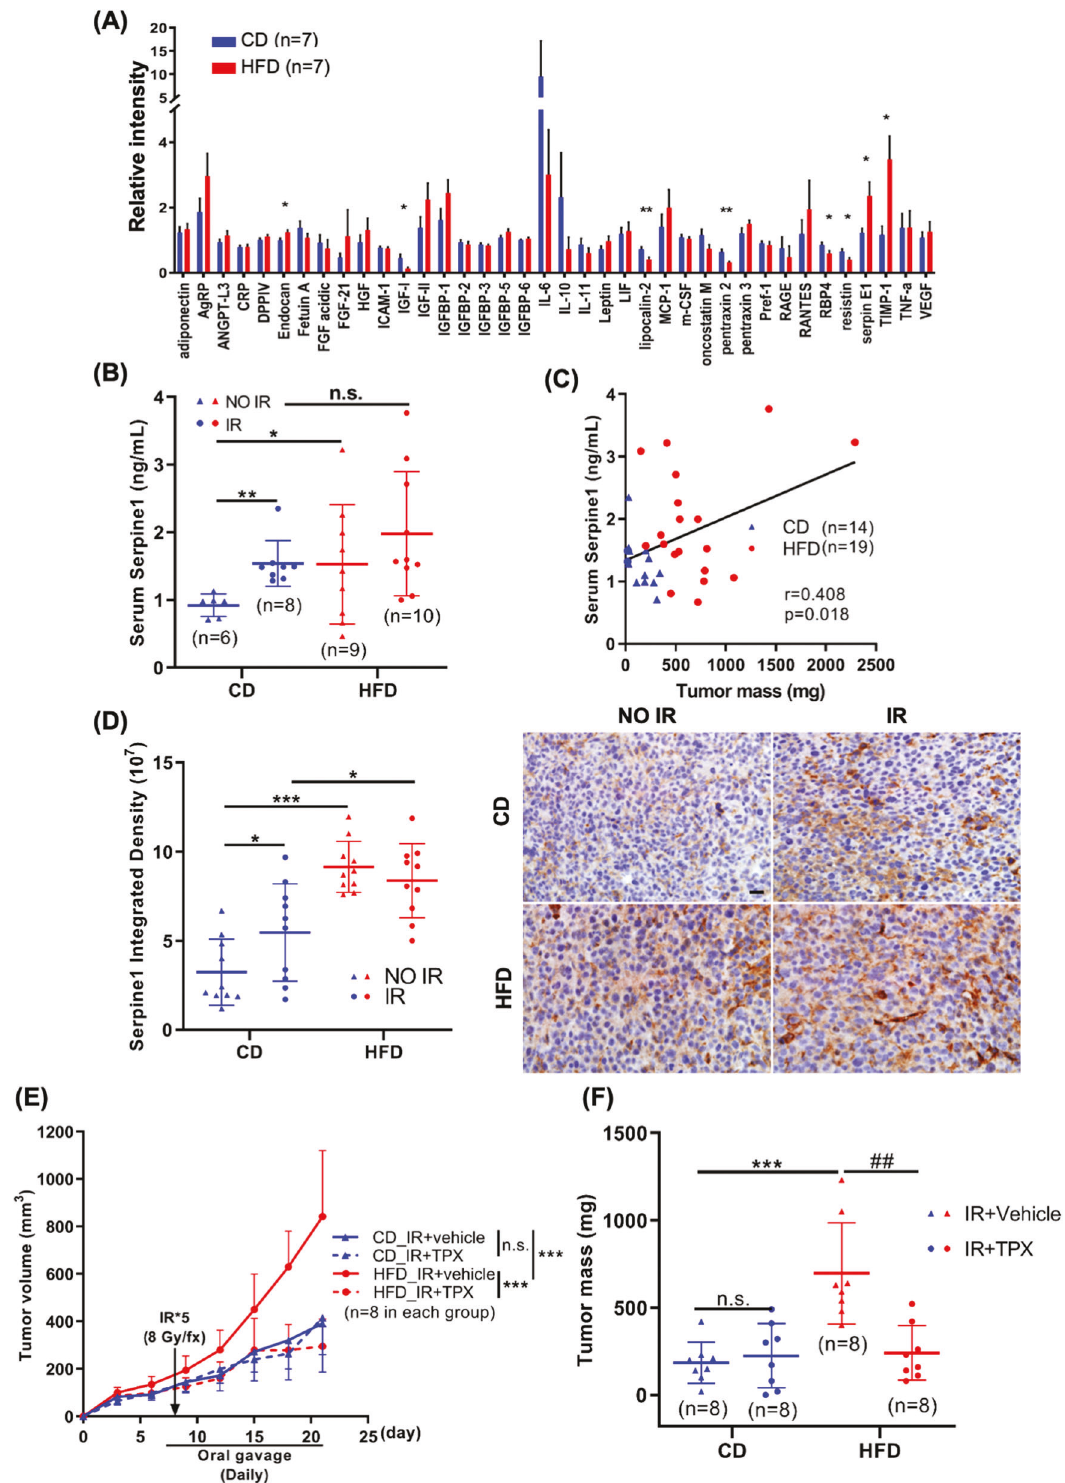
Fig. 2 SERPINE1 was increased in both circulation and tumors of DIO syngeneic TNBC mice. A Sera from C57BL/6 female mice fed with CD or HFD for 4 weeks were pooled and subjected to an adipokine array to identify the candidate adipokines that were related to DIO. N = 7 in each group. B Serum level of Serpine1 from both CD and HFD groups of mice were measured by ELISA. C Correlation between Serpine1 level and tumor weight in the mice fed with CD or HFD. D IHC staining of Serpine1 level in the tumor sections in each group of mice. 10 fi elds from 3 tumor sections were analyzed for each group. Representative images were shown on the right panel. Scale bar: 20 μ m. E , F Tumor volume was measured every 3 days post-tumor implantation, and mass was assessed after euthanasia. TPX: tiplaxtinin.